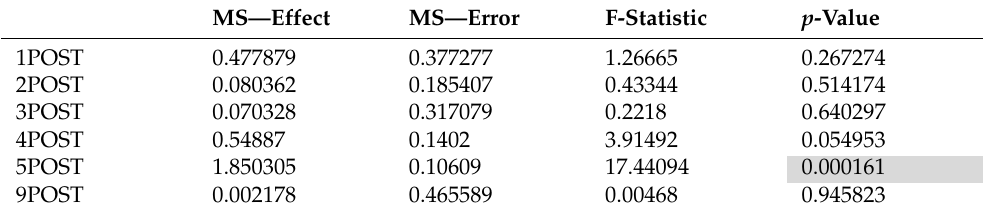
Table 3. Levene nonparametric test for the